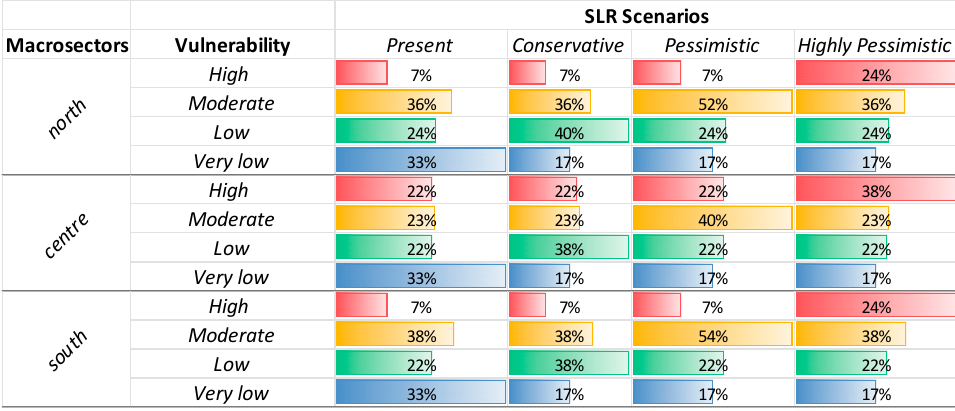
Figure 7. Posterior probability of vulnerability to SLR scenarios at the macro-sector level.